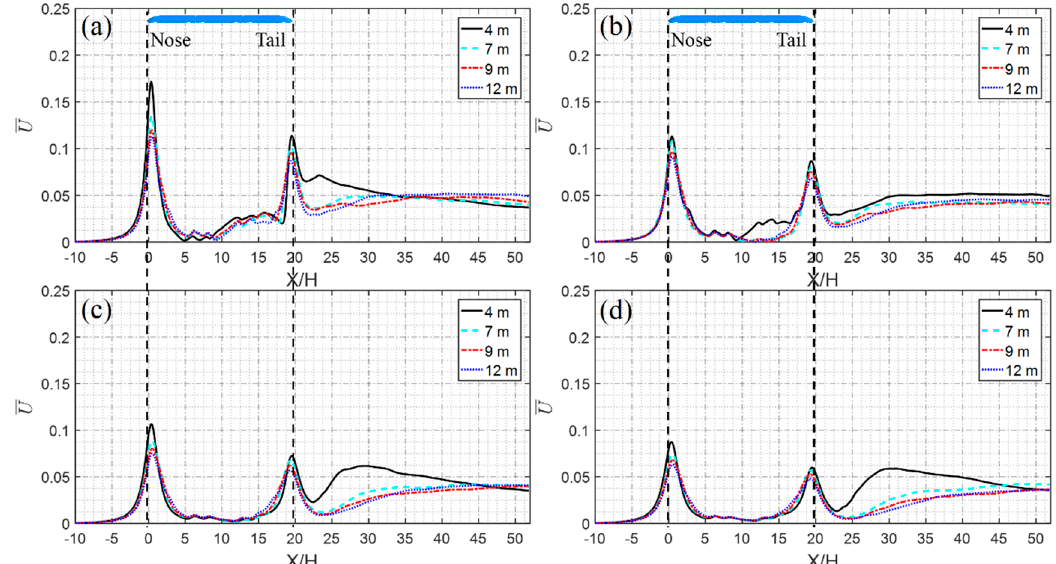
Figure 11. Time-averaged U of different nose lengths at height z = 1.4 m from TOR for ( a ) y = 2.5 m, ( b ) y = 3 m, ( c ) y = 3.5 m, and ( d ) y = 4 m (black dashed line on left is the nose and that on right the tail).